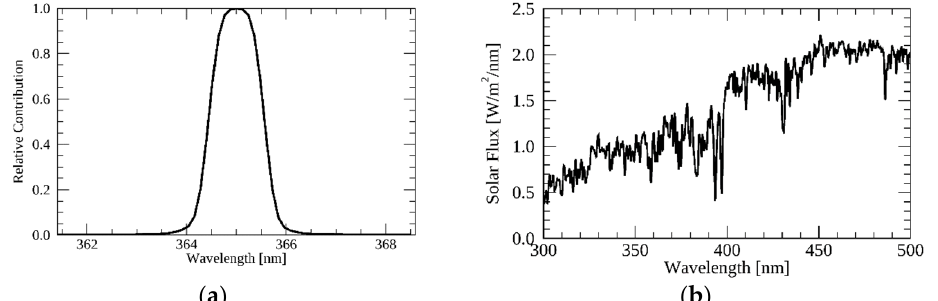
Figure 2. ( a ) Prelaunch GEMS SRF measured at 365.0 nm during laboratory characterization. ( b ) Synthetic GEMS solar irradiance obtained by convolving a high-resolution solar reference spectrum (Chance and Kurucz, 2010) and the prelaunch SRF.